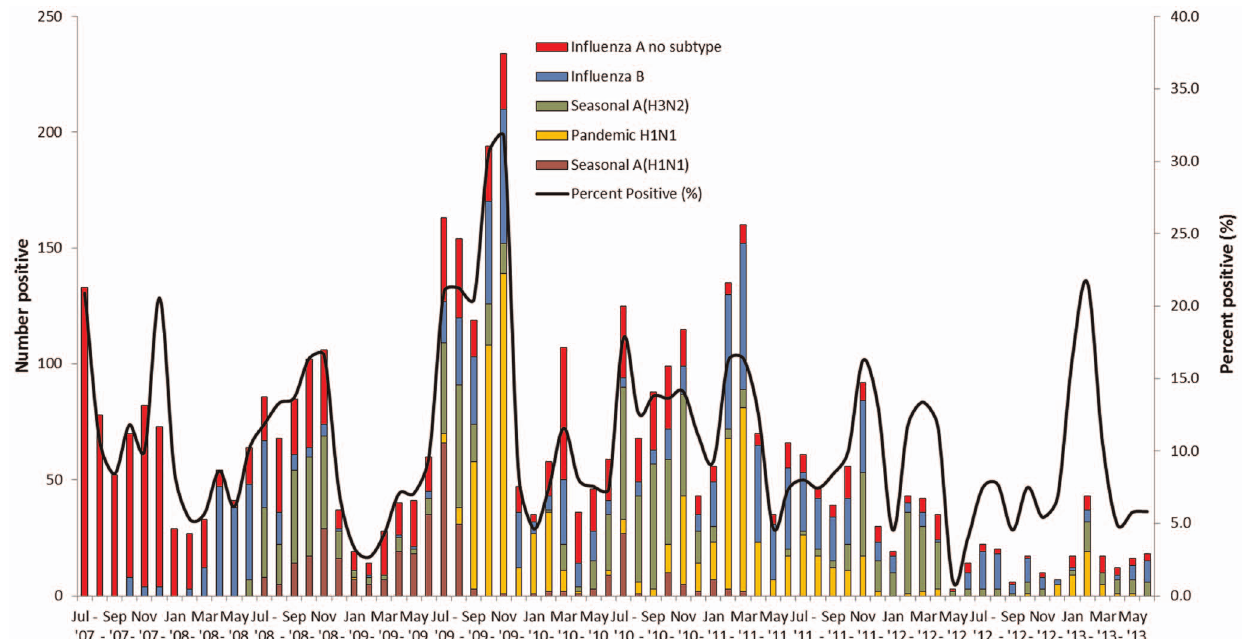
Figure 2. Seasonality of influenza for ILI and SARI patients, Kenya, July 2007–June 2013. Note: Smoothing done using the double exponential smoothing